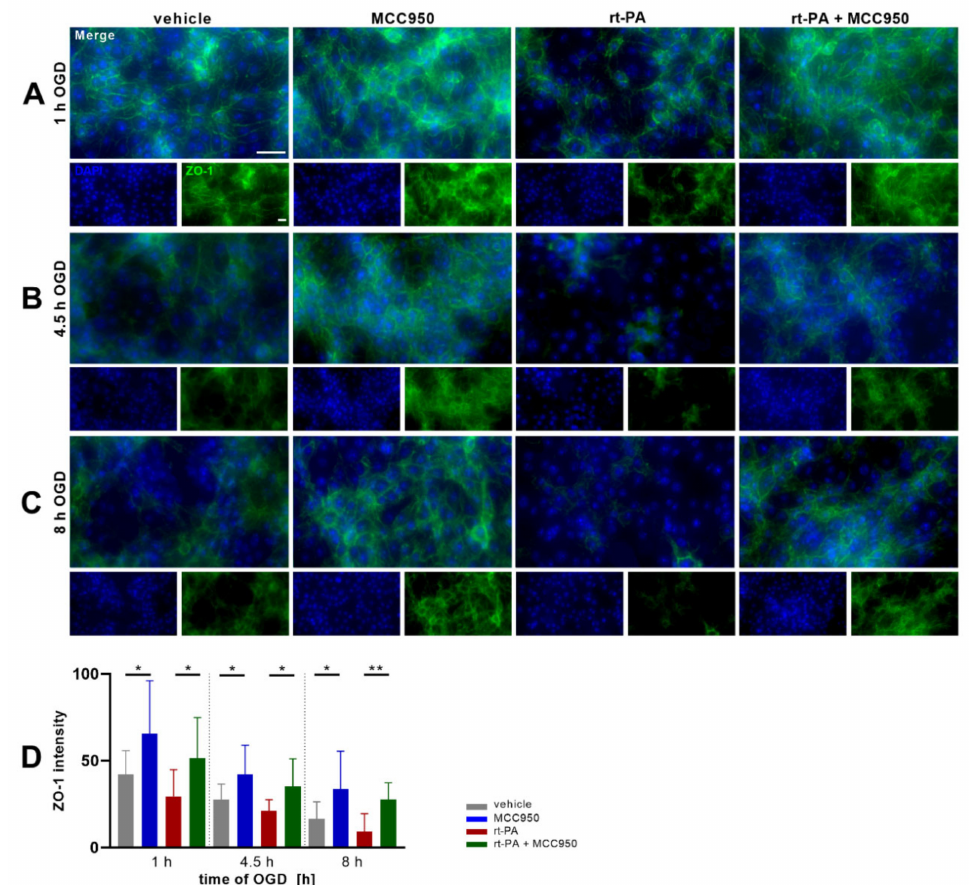
Figure 3. MCC950 treatment improves ZO-1 expression under OGD. Representative ZO-1 (green) and DAPI (blue) immunofluorescence stainings of bEnd5 after ( A ) 1 h, ( B ) 4.5 h, or ( C ) 8 h of OGD (1% O 2 , 5% CO 2 , 95% humidity, 37 ◦ C, 1 g/L glucose) either with vehicle, MCC950, rt-PA or dual rt-PA and MCC950 treatment. ( D ) Quantification of ZO-1 expression by intensity measure- ment of the immunofluorescent stainings ( n = 15 out of 3 independent experiments); 20 × objective; scale bar = 20 µ m; scale bars account for all images. Merged images are enlarged by a factor of 2. Data was analyzed by 1-way ANOVA with post hoc Tukey adjustment. * p < 0.05; ** p <